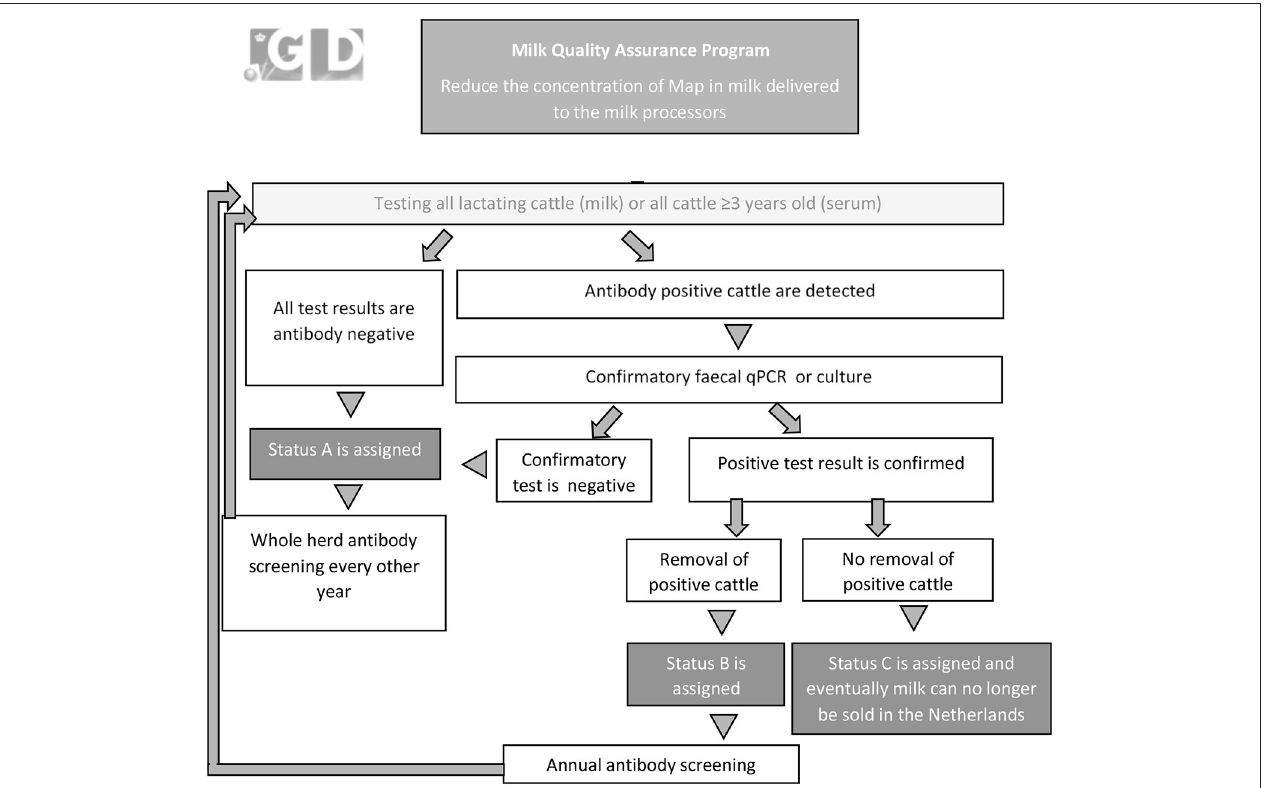
FIGURE 5 | Graphical overview of the mandatory Milk Quality Assurance Program for paratuberculosis (Royal GD, Deventer, the Netherlands) in the Netherlands that was initiated in